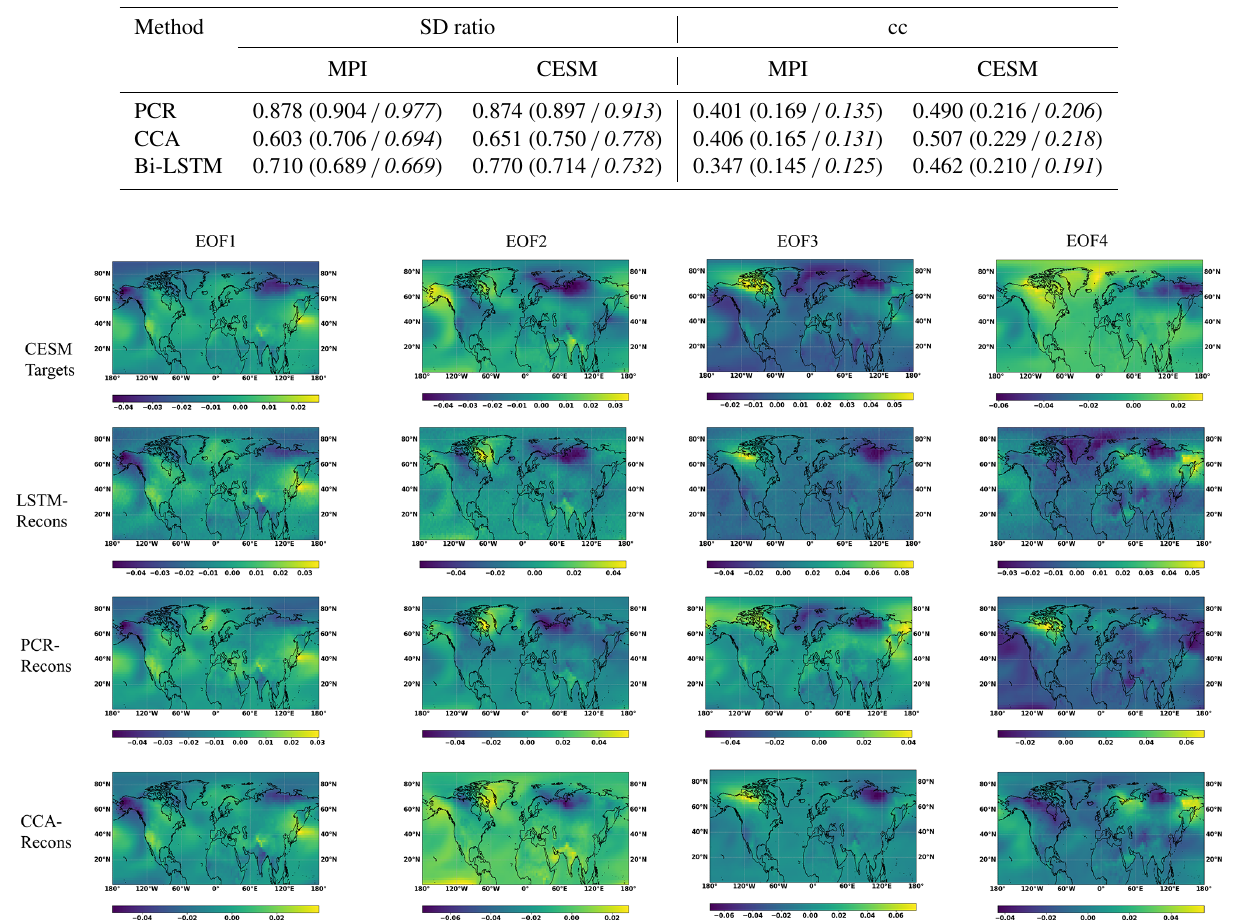
Table 1. Skill reconstruction statistics for the Northern Hemisphere mean temperature in the verification period for ideal PPEs. The table shows the result for three CFR methods (PCR, CCA, and Bi-LSTM) and two climate models (MPI and CESM). The numbers in parentheses indicate the skill statistics of white-noise-contaminated and red-noise-contaminated (italics) PPEs.